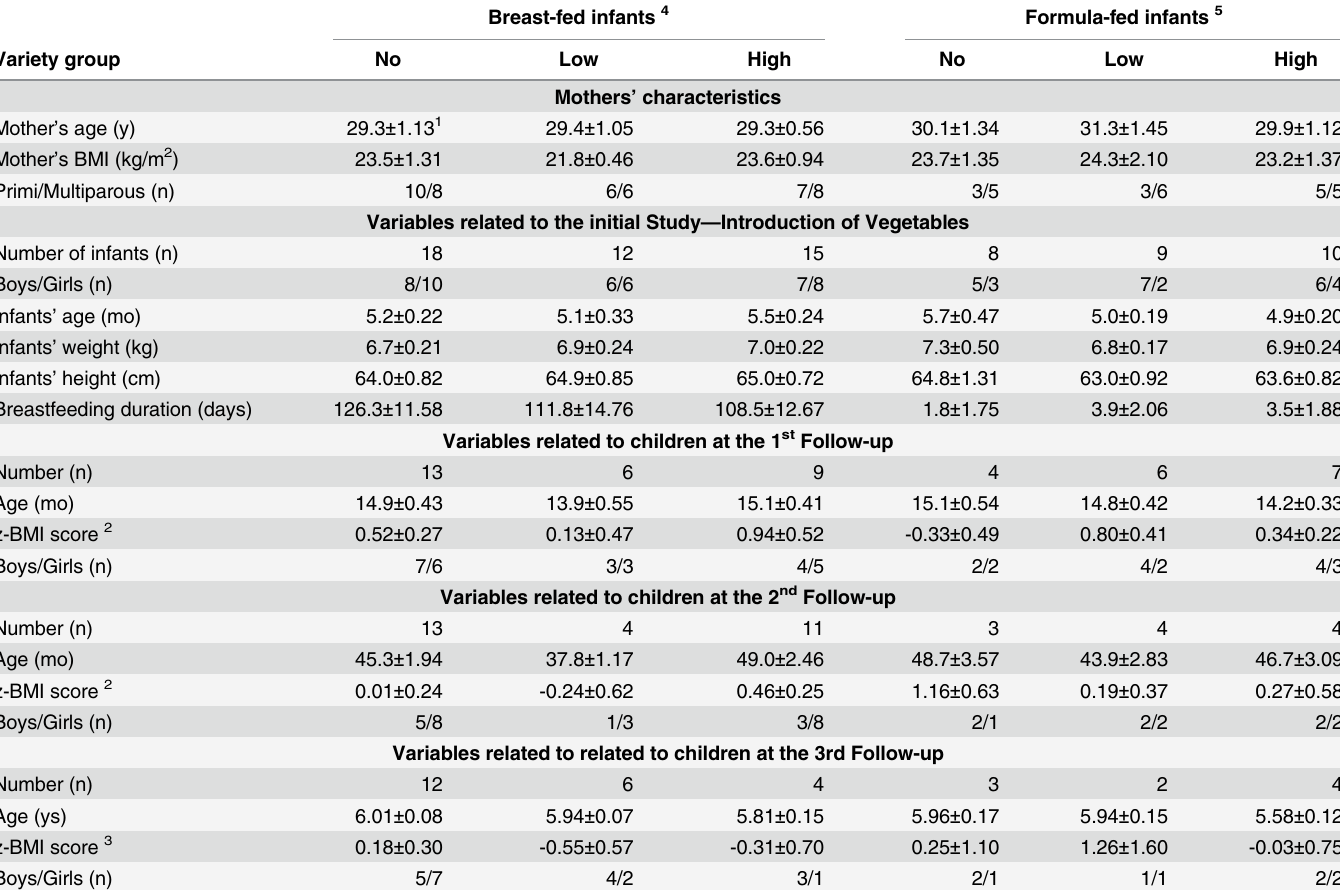
Table 1. Characteristics of the Dijon sample split by mode of milk feeding and variety exposure